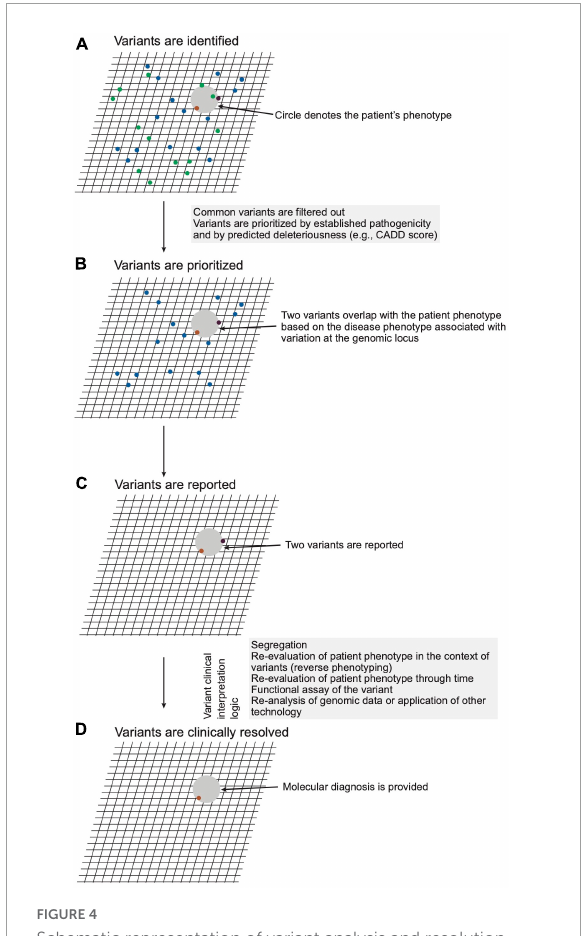
FIGURE4 Schematic representation of variant analysis and resolution. (A) A hypothetical patient phenotype (gray circle) is plotted on an imaginary grid in relation to disease phenotypes associated with genomic loci within which the patient carries variants (ochre, purple, green dots). (B) Given that the patient has a rare disorder, variants with high unaffected population frequencies (green dots) are eliminated from consideration. (C) The remaining variants are filtered considering precedent (prior association with phenotype), variant type